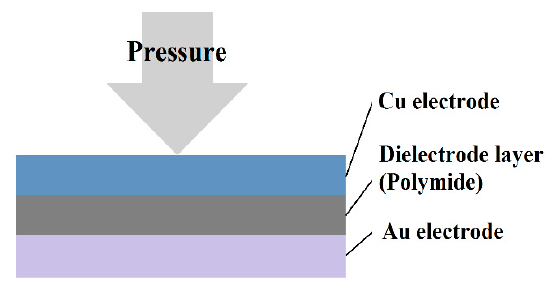
Figure 4. Schematic diagram of sensing principle of micro pressure sensor.